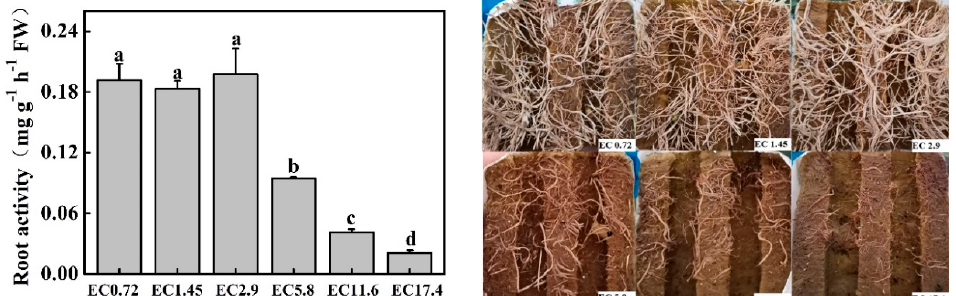
Figure 4. Effects of different EC treatments on root activity, and pictures of their roots after 25 days of treatment. EC0.72, EC1.45, EC2.9, EC5.8, EC11.6, and EC17.4 represent the different nutrient solution electrical conductivities of 0.72 dS m − 1 , 1.45 dS m − 1 , 2.9 dS m − 1 , 5.8 dS m − 1 , 11.6 dS m − 1 , and 17.4 dS m − 1 . Data represent the mean ± SD ( n = 3). Different letters indicate significant differences at α = 0.05 based on the Least Significant Difference test.